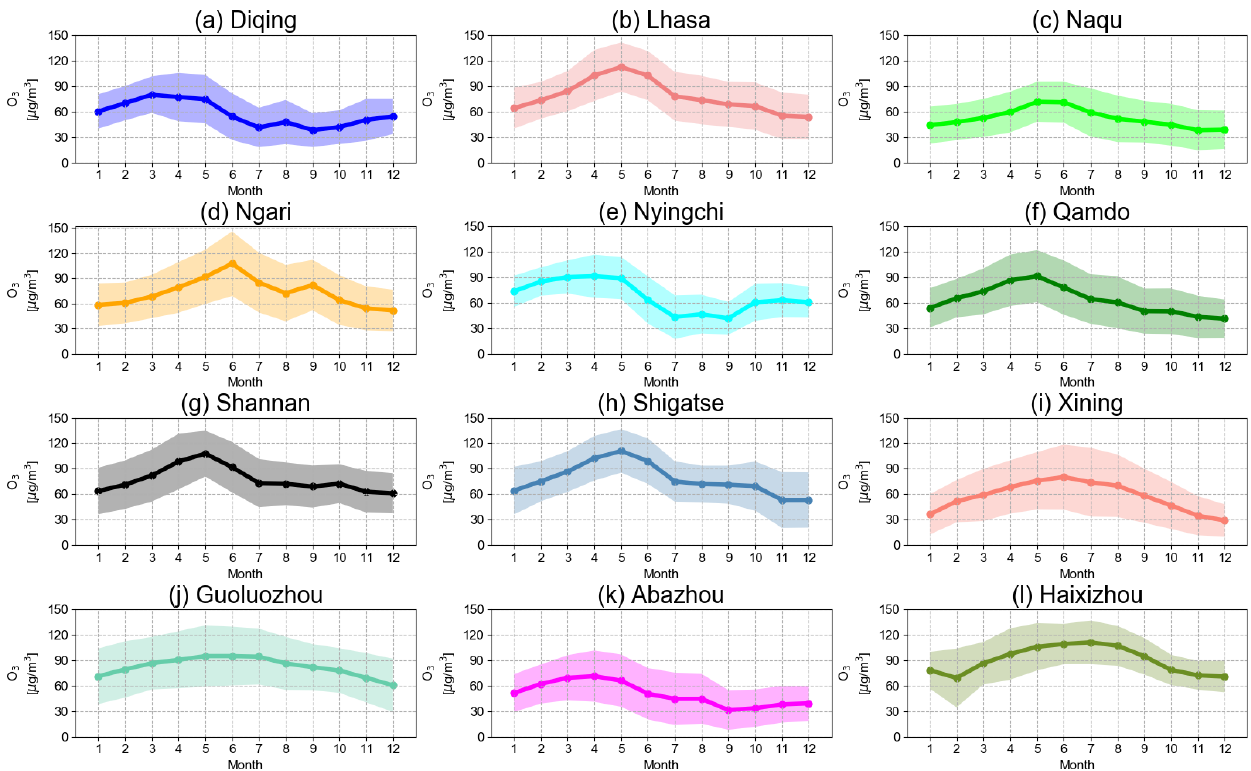
Figure 4. Monthly mean time series of surface ozone (units: µgm − 3 ) between 2015 and 2020 in each city over the QTP. The vertical error bar is 1 σ standard variation (SD) within that